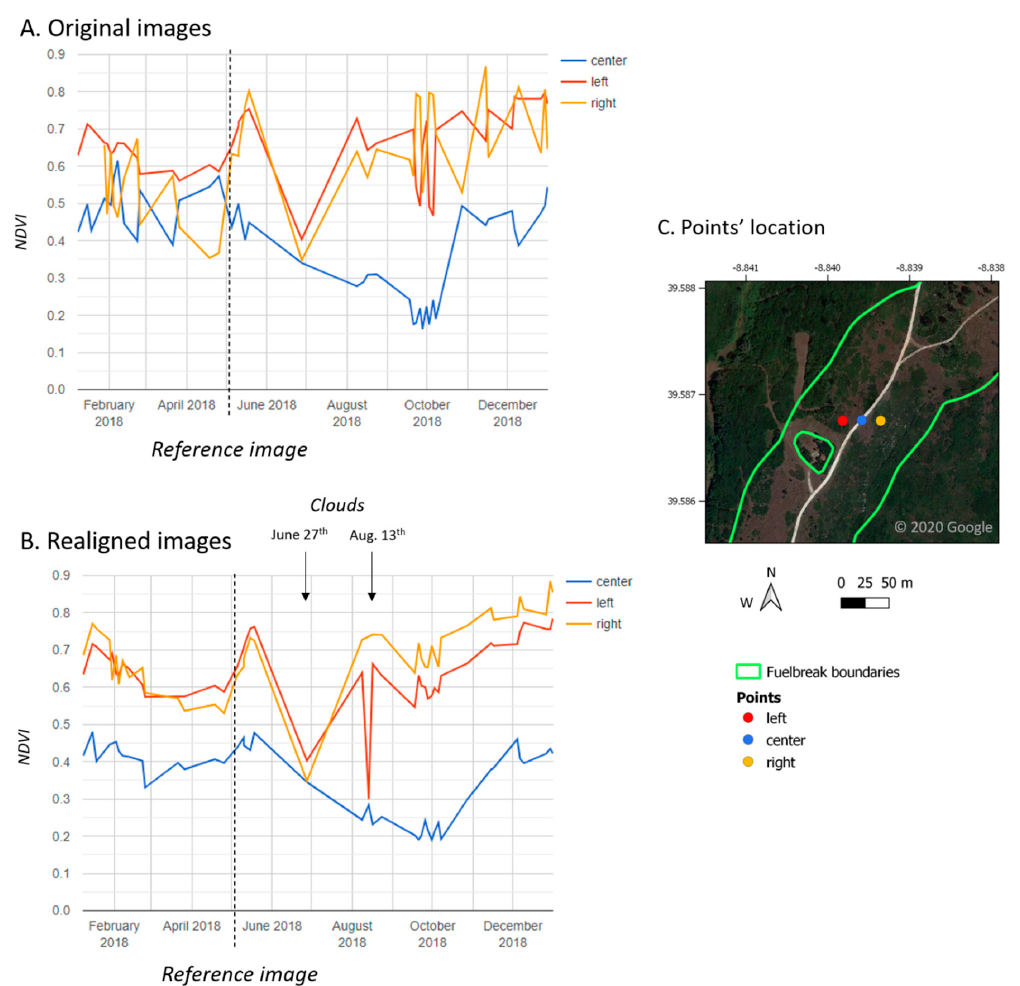
Figure 4. Time series ( A ). before and ( B ). after coregistration of three points located on an unpaved road of the fuel break (center, in blue), 20 m on its left (red) and 20 m on its right (orange), with ( C ). the location of the three points on an aerial view of the fuel break. The images of the tile are all coregistered using a reference image (vertical dash line).